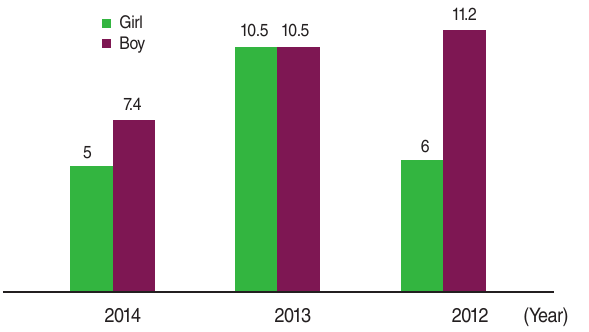
Figure 2. The incidence of congenital hypothyroidism in terms of season in 2012-2014 per thousand live births.